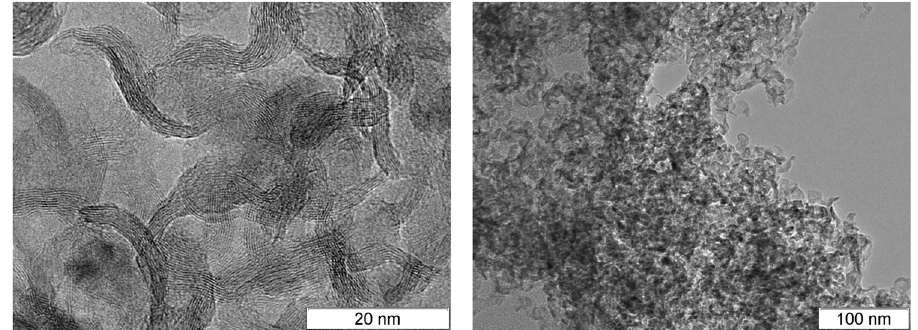
Figure 1. Carbon residuum of TATB detonation.